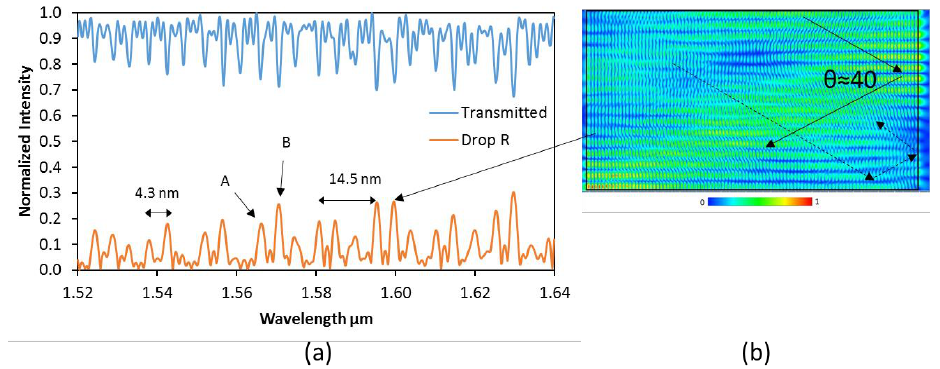
Figure 2. Theoretical ( a ) Spectra for the transmitted and drop R port and ( b ) the electromagnetic field inside the cavity for λ = 1599.6 μm obtained by FDTD.